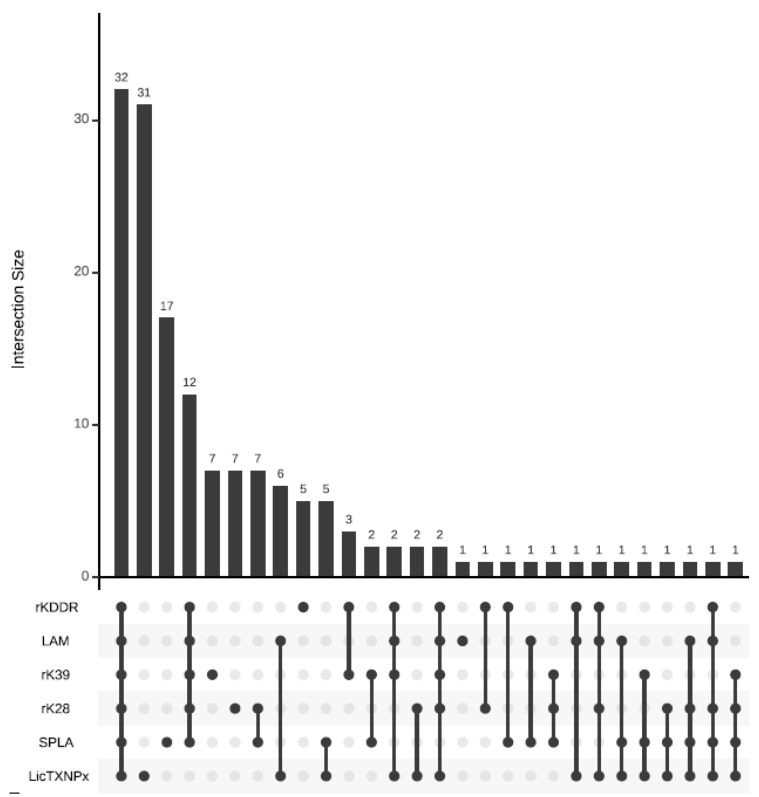
Figure 2. UpSet Plot depicting seropositivity intersect to rKDDR, LAM, rK39, rK28, SPLA, and LicTXNPx in the PT cohort. The black bars in the graph represent the absolute number of positive events of each intersection, associated with the six parameters evaluated. Under each black bar, the connecting line represents the intersection of the tested parameters. If no intersecting line is present it means that dogs only positive to one event are being quantified in the upper black bar.